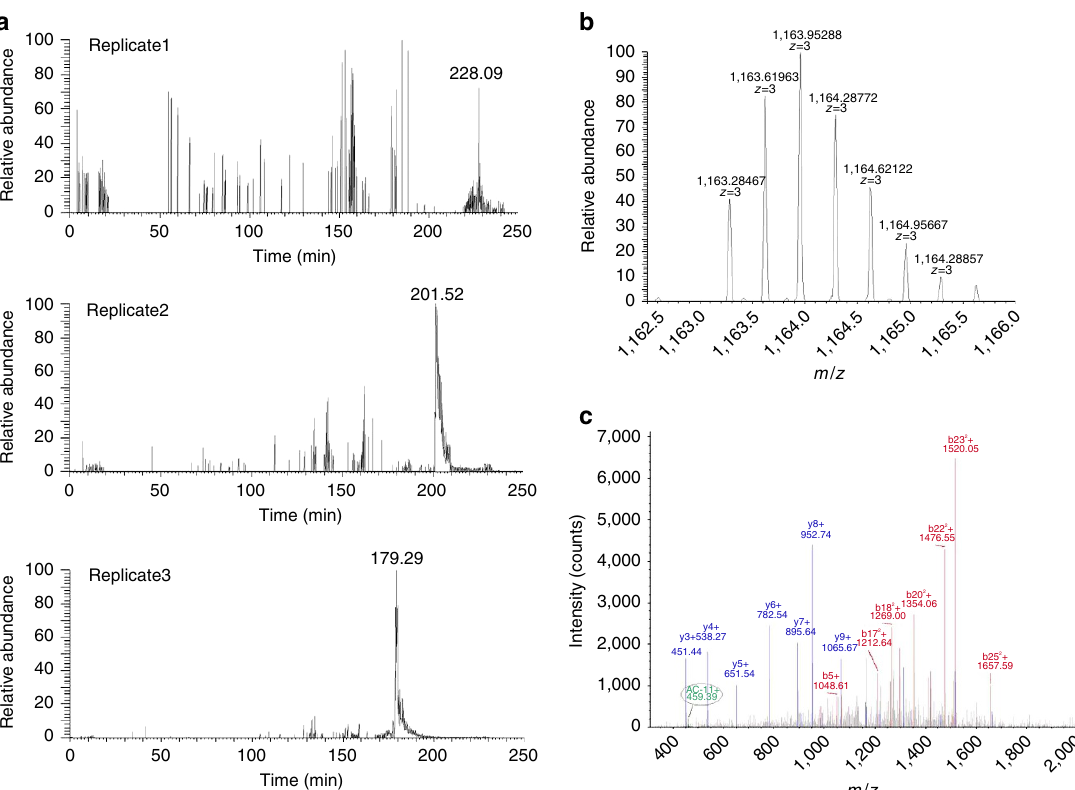
Figure 6 | MS/MS-analysis. ( a ) Extracted ion chromatograms of the triply charged species of the KCNE1 peptide 42 LEALYVLMVLGFFGFFTLGIMLSYIR 67 with AC-10 modification (1163.28m/z) identified across three replicate LC-MS/MS analyses. Isotope pattern of the [M þ 3H] 3 þ precursor of AC-10 modified peptide 42 LEALYVLMVLGFFGFFTLGIMLSYIR 67 ( b ) and corresponding MS/MS spectra with b- (red) and y-ion annotation (blue) ( c ). The characteristic marker ion of AC-10 (459.39 m/z ) is observed in the MS/MS spectrum. The consecutive y-ion series y 2 –y 9 of respective amino acids is nicely displayed.